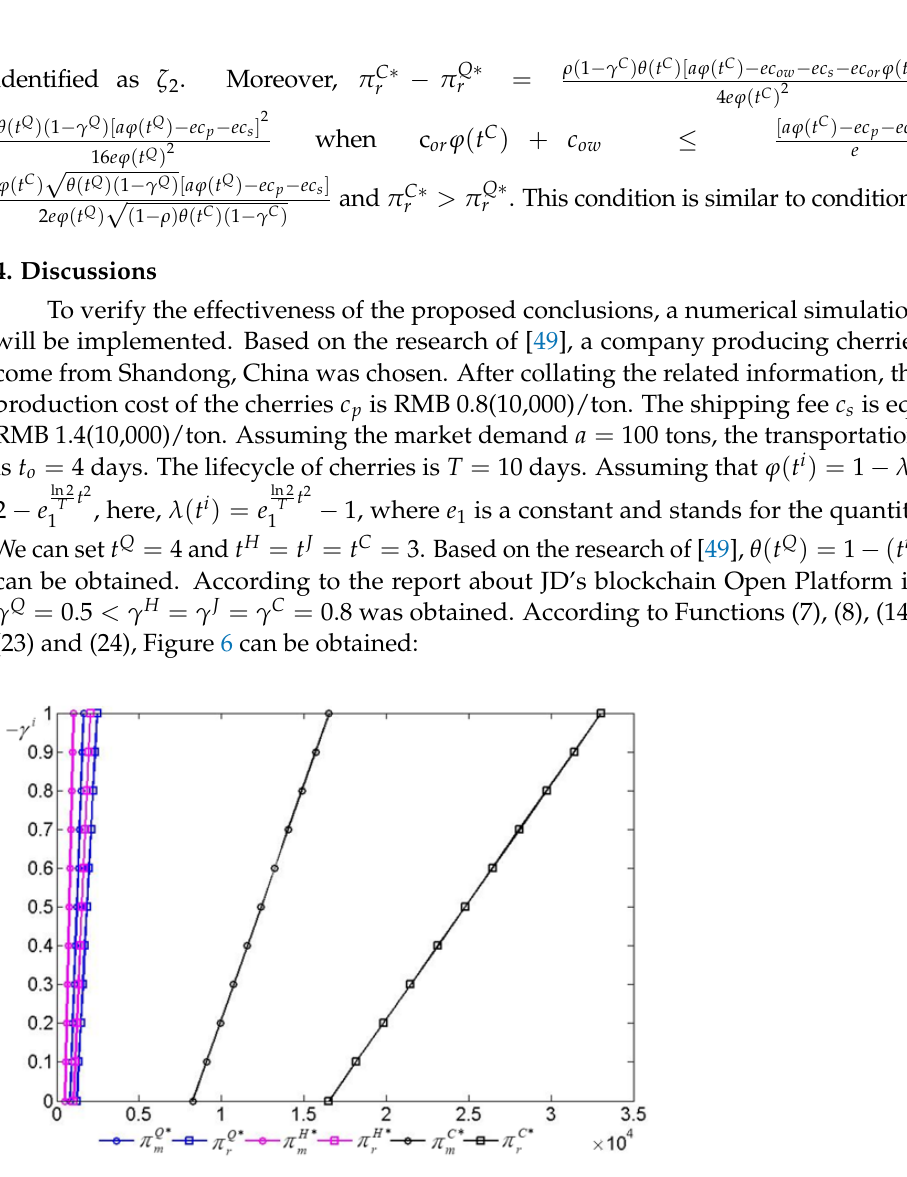
Figure 6. Relationships between chain members’ revenues in different situations and the unreliabil- ity coefficient of the freshness